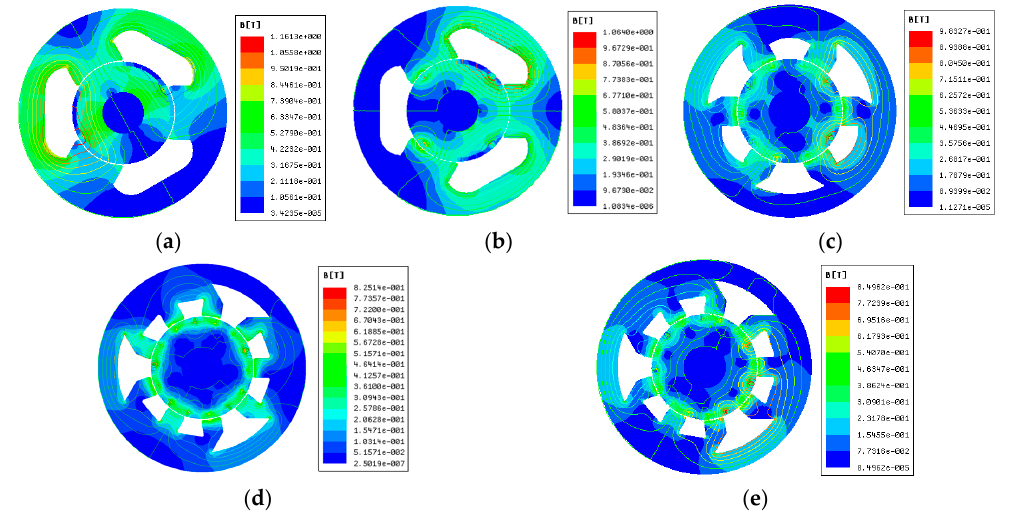
Figure 5. Stators with different auxiliary poles n aux for FE simulations. ( a ) n aux = 1; ( b ) n aux = 2; ( c ) n aux = 3.